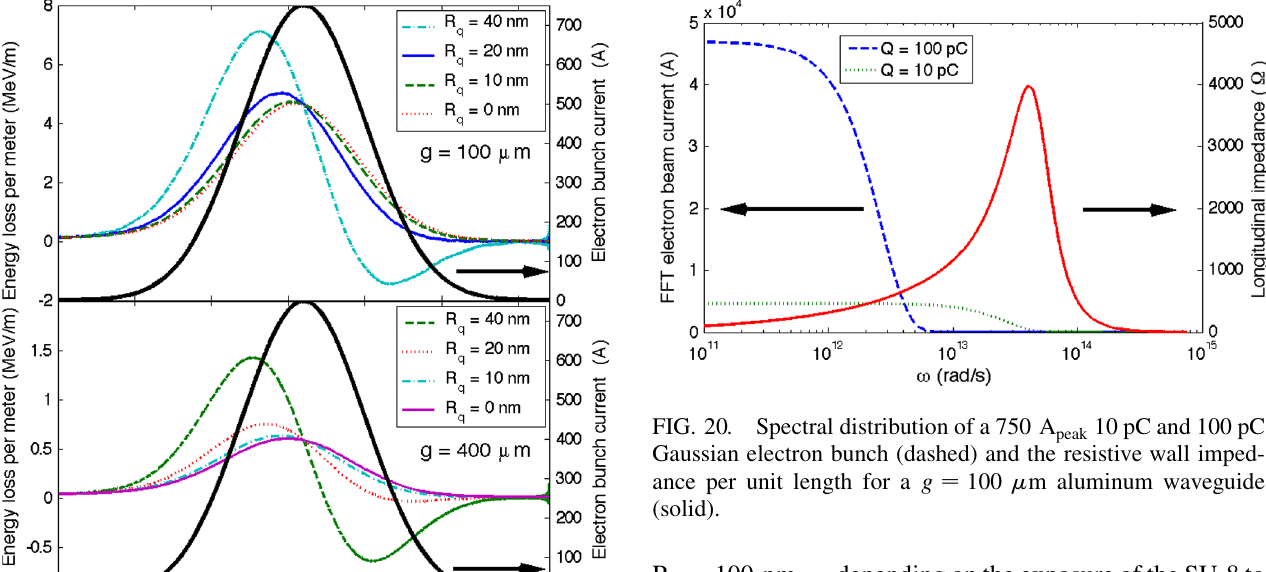
10 pC and 100 pC peak